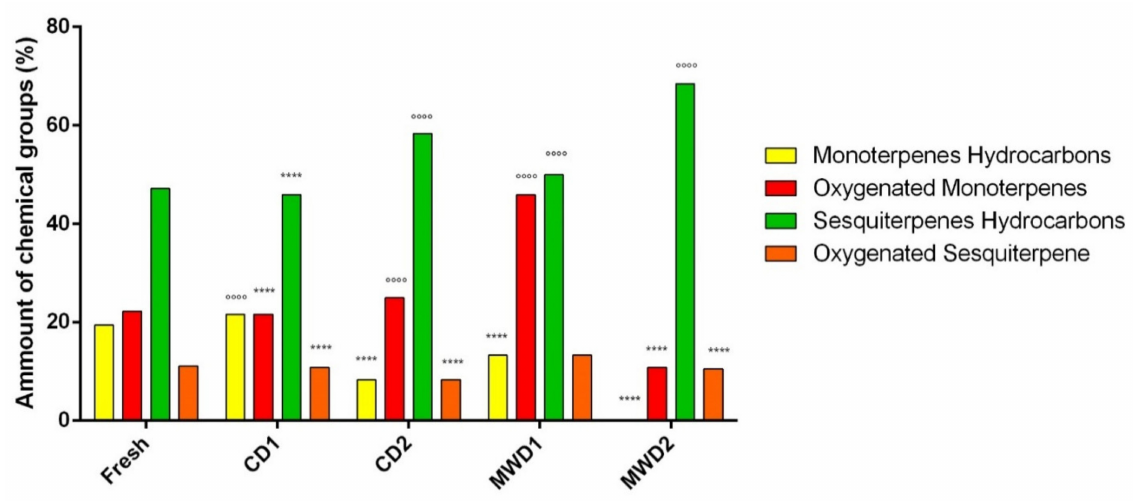
Figure 5. Comparison of percentages of main chemical groups (%) of fresh basil and samples dried by different methods. Statistical references: **** (component decreases) = p < 0.0001 vs. fresh sample according to two-way ANOVA followed by Dunnett’s multiple comparisons test, at 5% level probability; ◦◦◦◦ (component increases) = p -value < 0.0001 vs. fresh sample according to two-way ANOVA followed by Dunnett’s multiple comparisons test, at 5% level